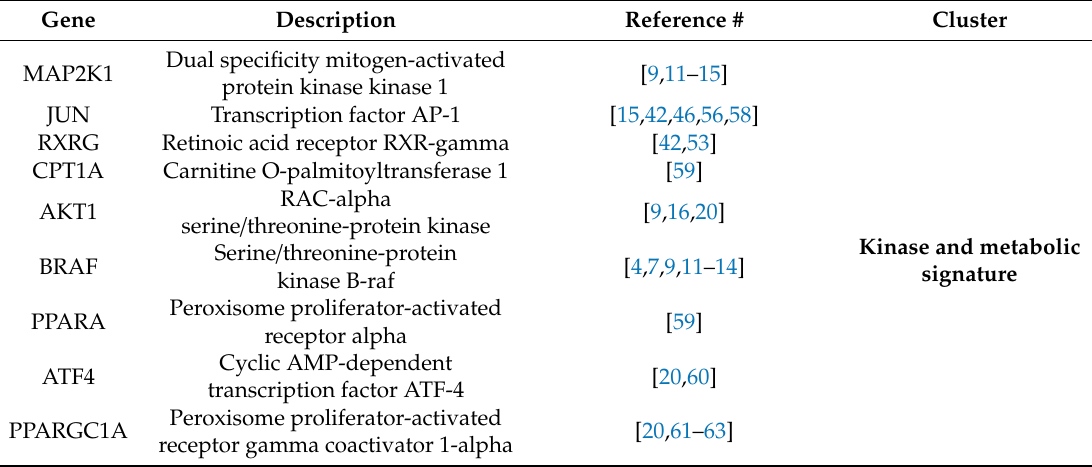
Table 1. List of 25 top genes relevant for melanoma stem cells and resistance to target therapy.